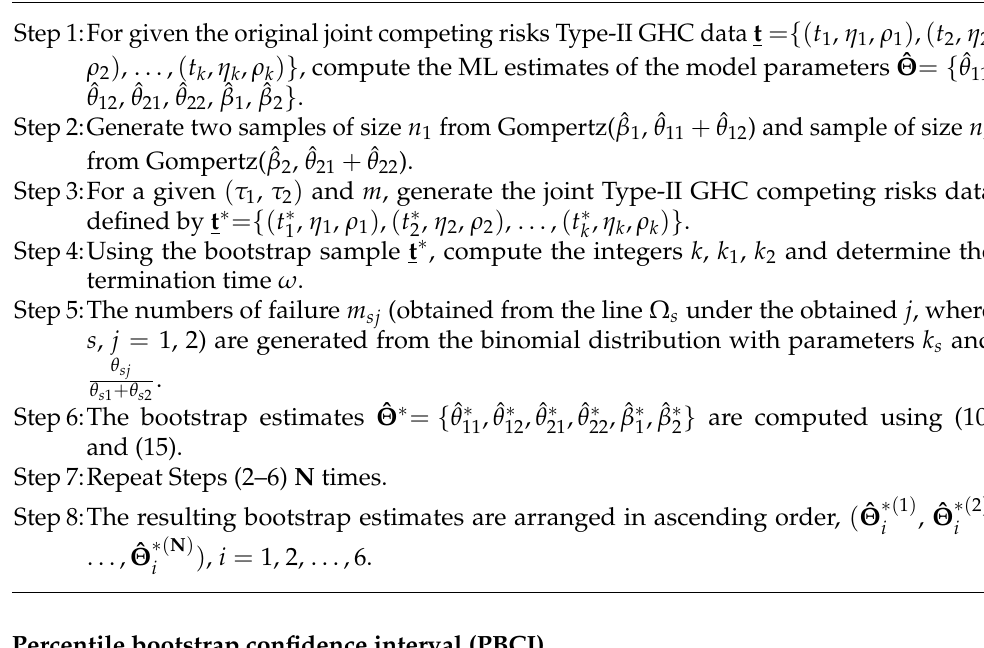
Algorithm 1 Percentile bootstrap- p and bootstrap- t confidence